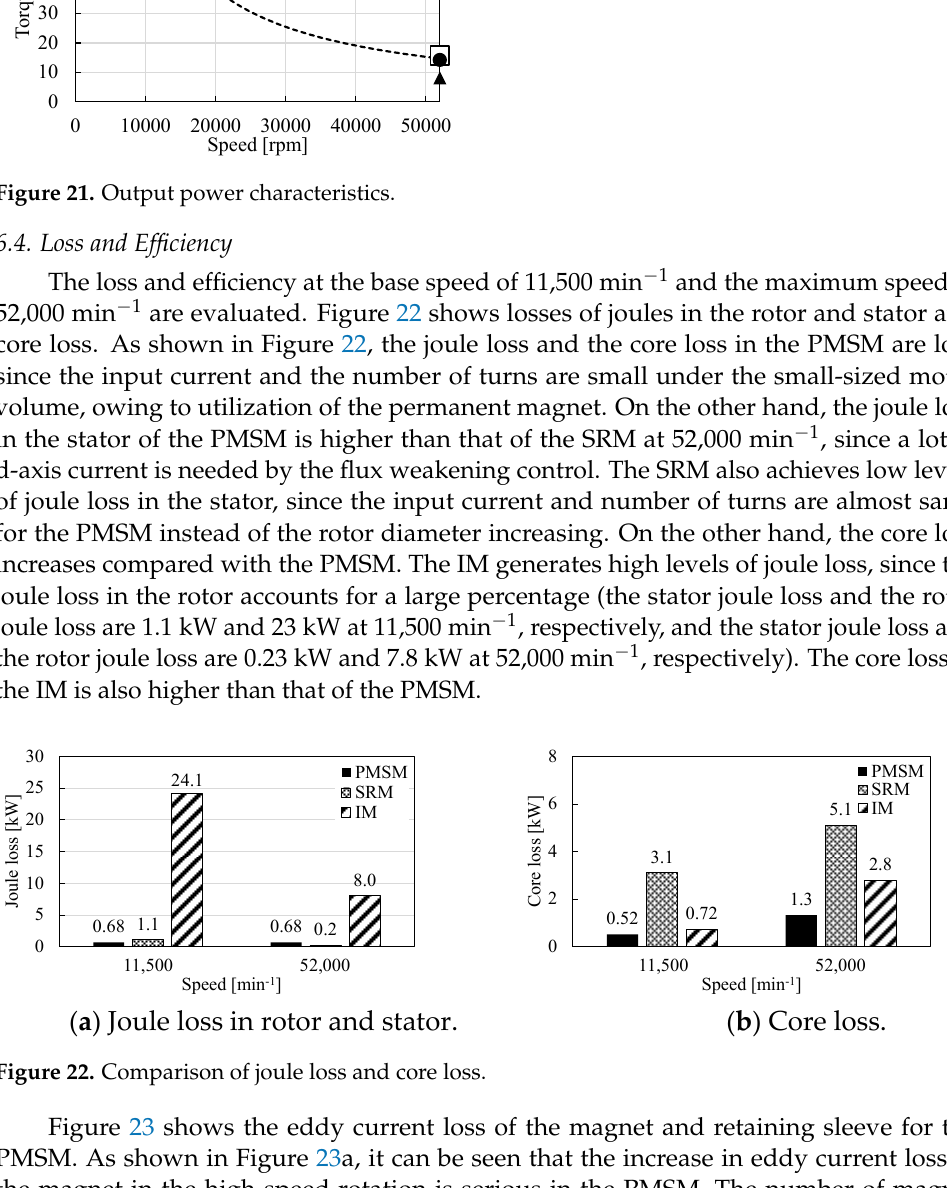
( b ) Eddy current loss of retaining sleeve. Figure 23. Eddy current loss of PMSM.